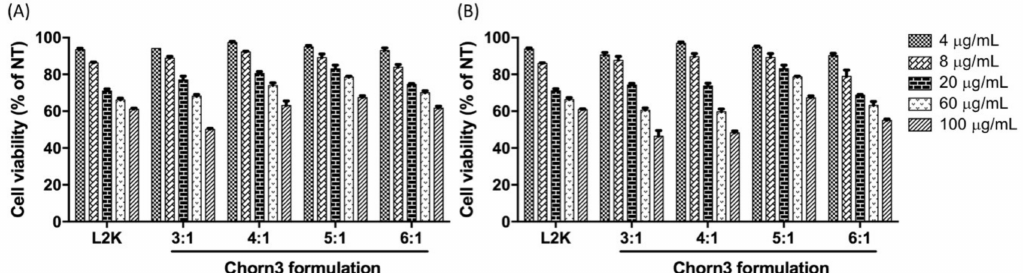
Figure 4. Cytotoxicity assay for Chorn3 formulation. ( A ), HeLa cells ( B ), HepG2